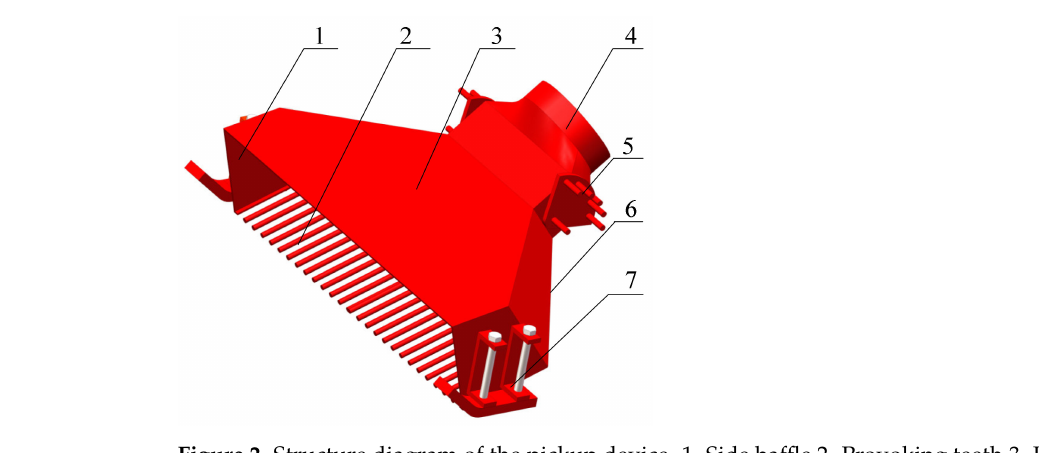
Figure 2. Structure diagram of the pickup device. 1. Side baffle 2. Provoking teeth 3. Upper baffle 4. Negative pressure airflow interface 5. Angle adjusting rod 6. Underside baffle 7. Depth limiting